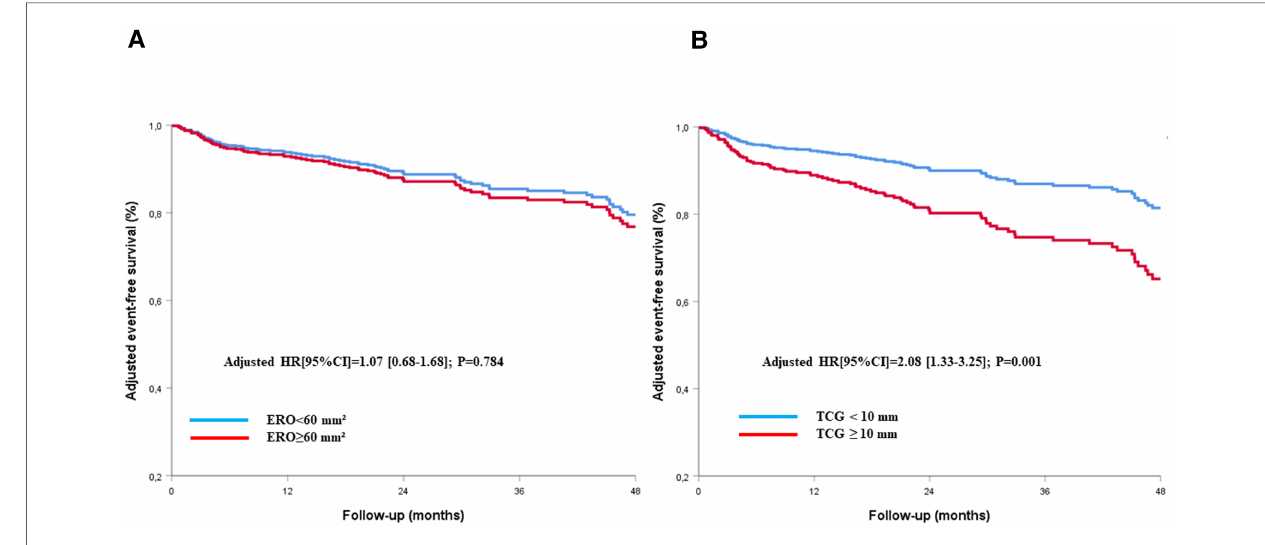
FIGURE 5 Cox-adjusted curves of freedom from cardiac death for patients with TR according to the de fi nition of very severe TR using EROA ( A ) or TCG ( B ). EROA, effective regurgitant ori fi ce area; TCG, tricuspid coaptation gap; TR, tricuspid regurgitation.